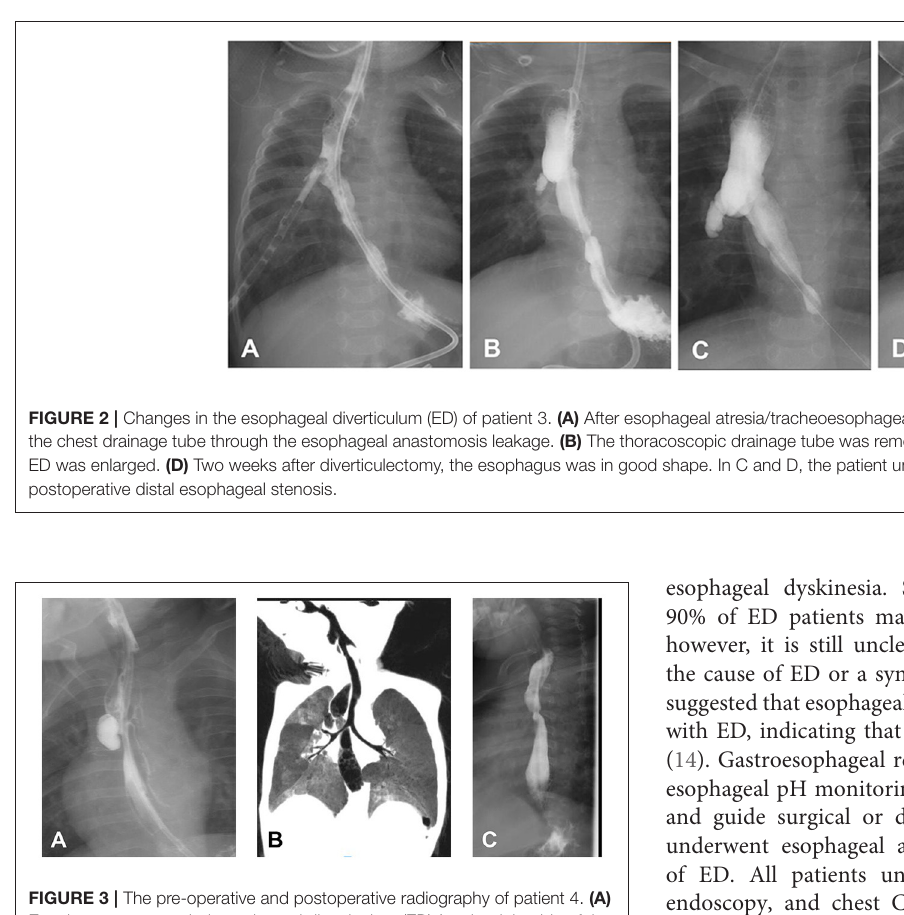
FIGURE 3 | The pre-operative and postoperative radiography of patient 4. (A) Esophagogram revealed esophageal diverticulum (ED) (on the right side of the esophagus) combined with recurrent tracheoesophageal fistula (on the left side of the esophagus). (B) ED on chest computed tomography. (C) Two weeks after